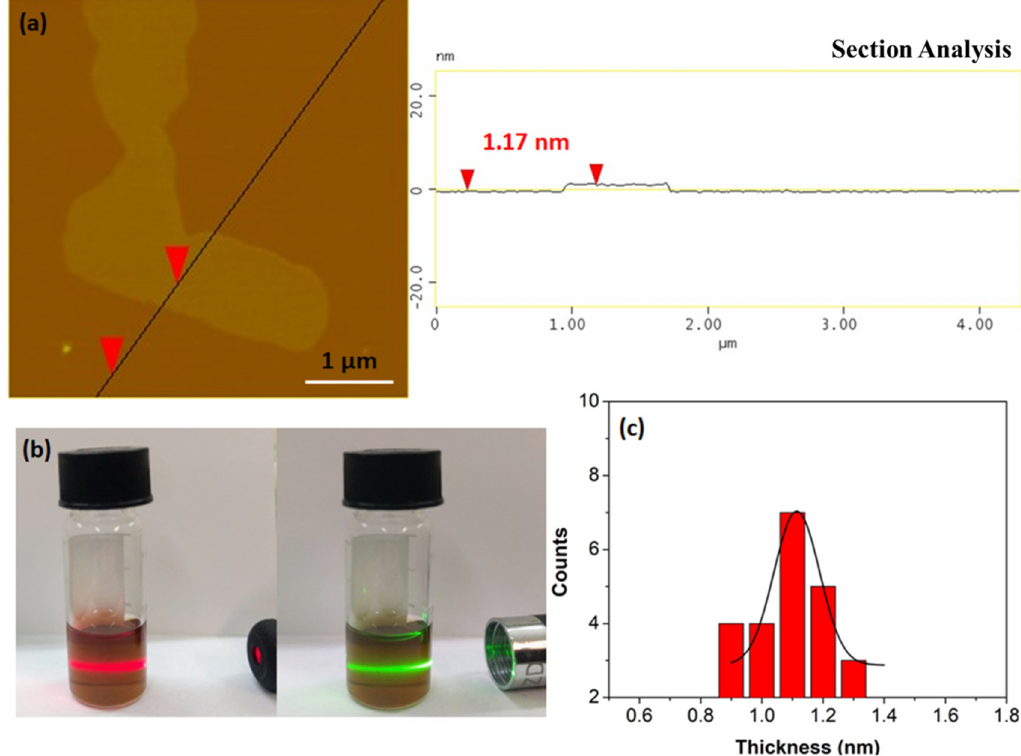
Figure 8. ( a ) Atomic force microscopy (AFM) height profile of a single sheet. ( b ) The colloidal dispersion of the single sheets in DMF exhibiting a strong Tyndall effect using a red or green laser pointer. ( c ) AFM statistical analysis of thickness for 25 randomly selected nanosheets.